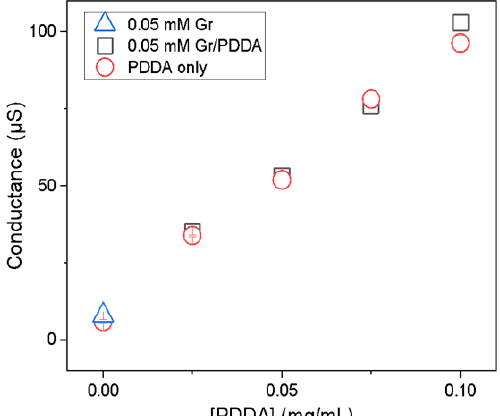
Figure 6. Conductance of a 0.05 mM gramicidin (Gr) nanoparticles (NPs) dispersion in the absence (∆) or presence of poly (diallyldimethyl ammonium chloride) (PDDA) (□ ). PDDA conductance in absence of Gr was also measured over a range of [PDDA] (o).